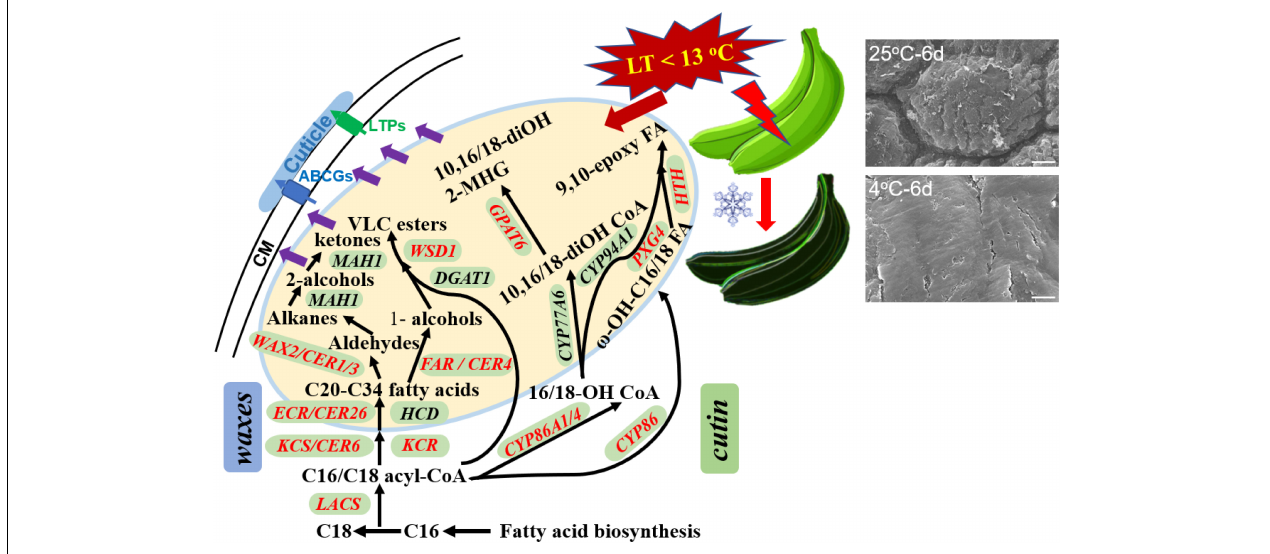
FIGURE 9 | The overall changes in cuticle biosynthesis response to chilling temperature in banana fruit. The structural genes involved in cuticular wax and cutin monomer biosynthesis were differentially regulated (labeled in red) by low temperature in response to the appearance changes during